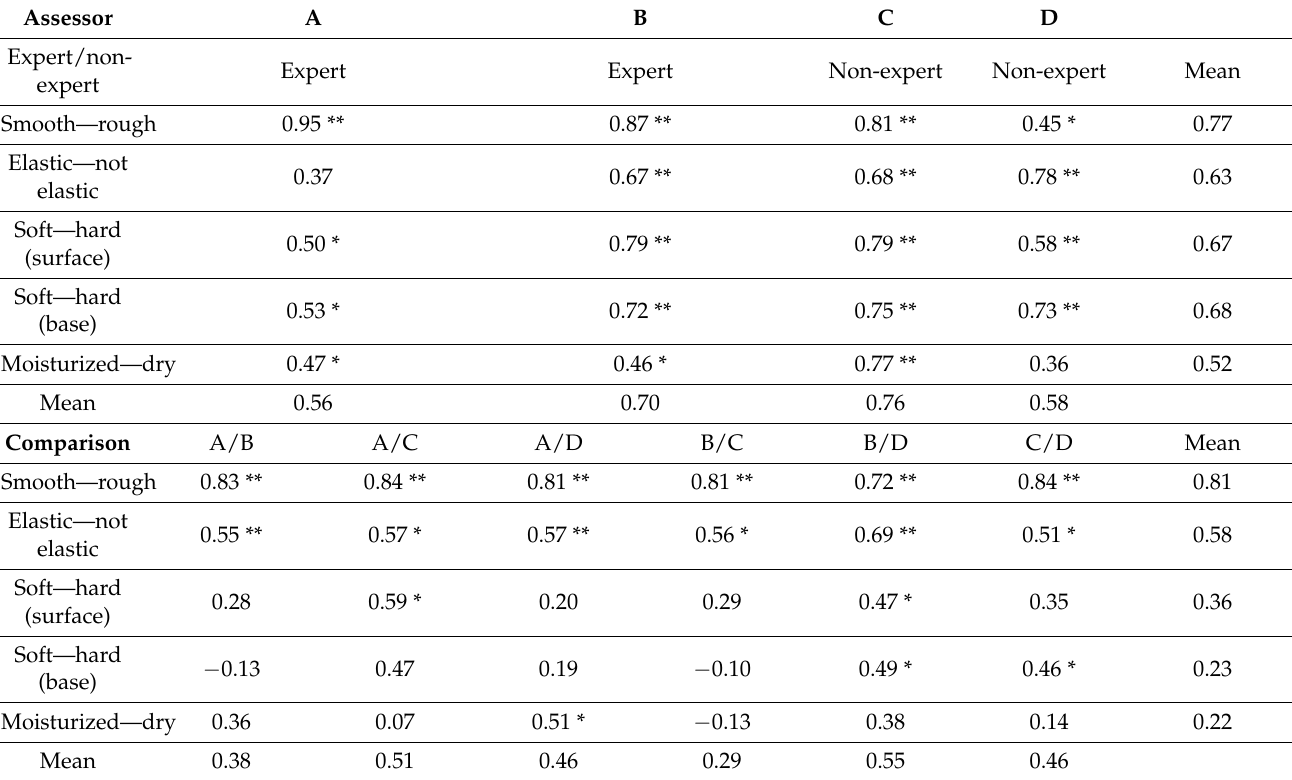
Table 7. Intra- (top) and inter-assessor (bottom) Pearson’s correlation coefficients.